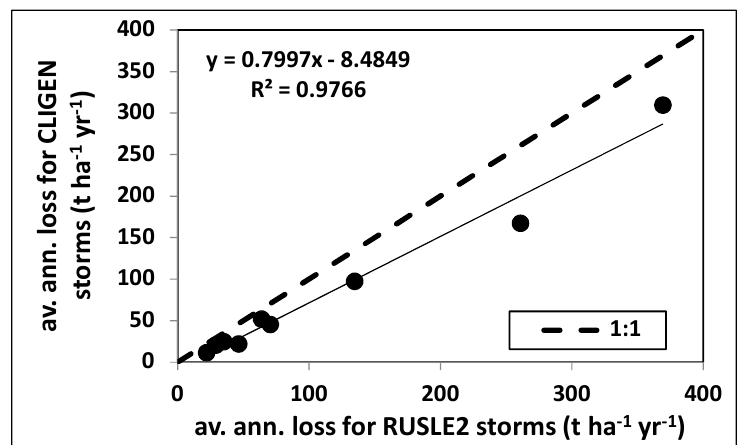
Figure 7. Relationship between average annual soil loss produced by CLIGEN storms and average annual soil loss produced by RUSLE2 storms at the nine locations when the standard RUSLE2 erosivity density values were used to predict event erosivity and rainfalls of less than 12.5 mm were omitted (source: Kinnell [55]). Table 2. RUSLE2 R factor and soils at the locations with unit plots where CLIGEN was used as a weather